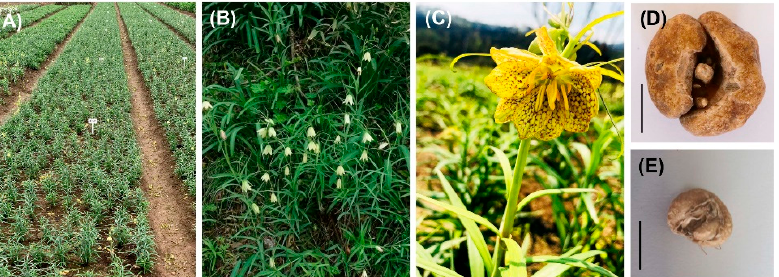
Figure 6. Artificial and imitating wild cultivation of F. thunbergii . ( A ). The large-scale artificial cultivation of F. thunbergii in Zhangshui town of Ningbo in Zhejiang Province of China. ( B ). The imitating wild cultivation of F. thunbergii in Siming Mountain in Zhejiang Province of China. ( C ). The F. thunbergii Flos. ( D ). The bulb of F. thunbergii by artificial cultivation. Bar: 1 cm. ( E ). The bulb of F. thunbergii by the imitating wild cultivation. Bar: 1